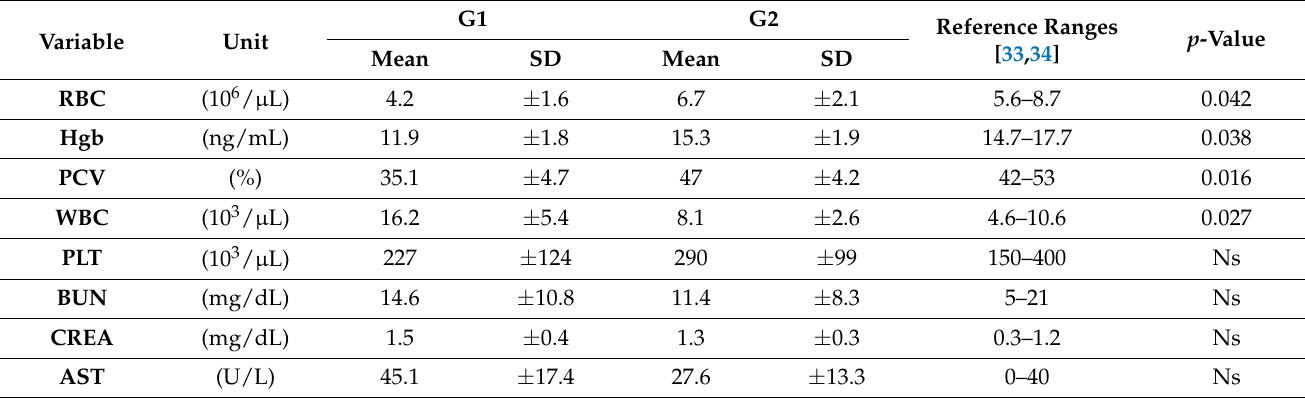
Table 2. Hematological and biochemical variables in dogs with gastrointestinal nematodes (G1) and in healthy dogs